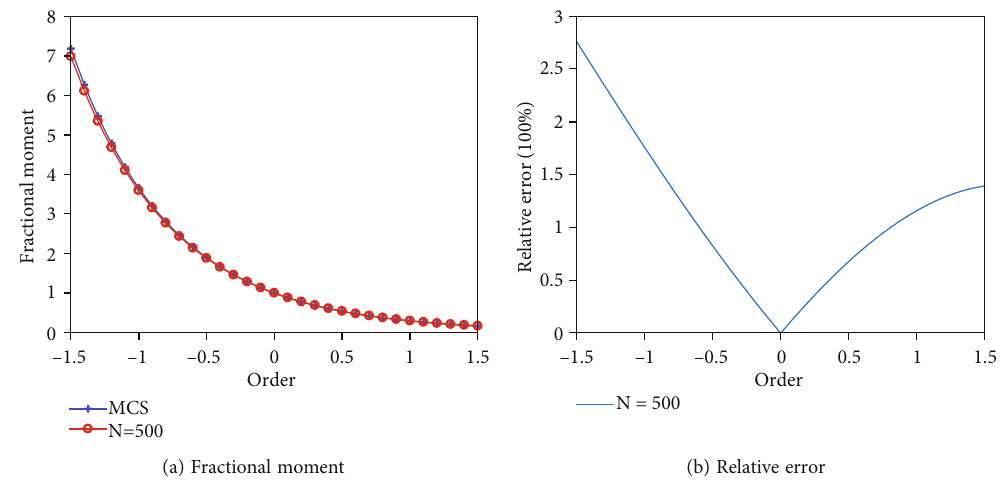
Figure 7: Fractional moments and relative error of the normalized response (the nonlinear structural system). Table 5: The value of the objective function for the nonlinear structure. m = 3